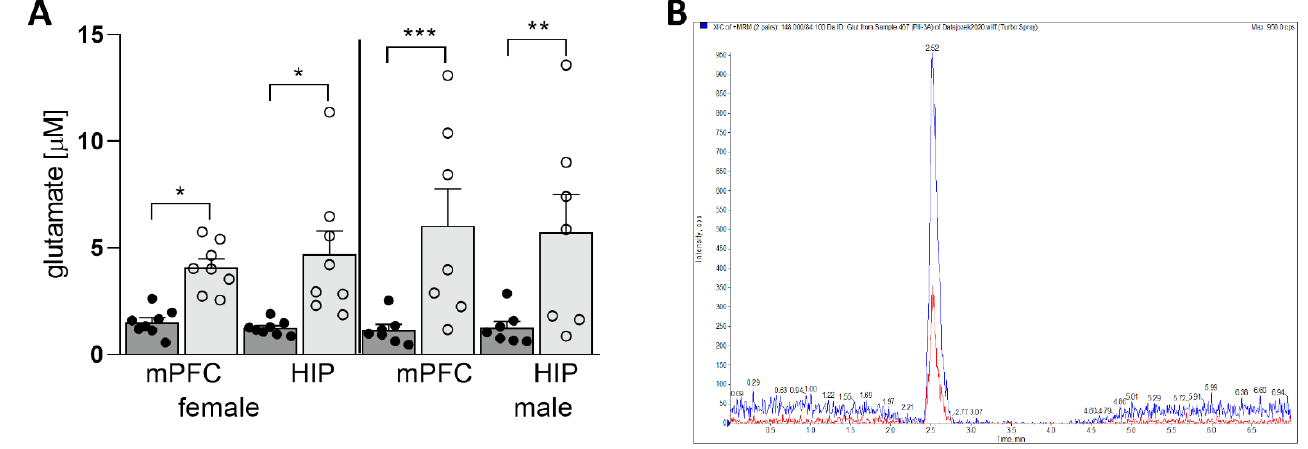
Figure 4. Concentration of extracellular Glu in the mPFC and HIP of the offspring ( A ). SCD — dark gray bars with black dots as individual data points, HSD — light gray bars with transparent dots as individual data points. Representative chromatogram ( B ). Blue peak — Glu; red peak — internal standard (Glu C13). * p < 0.05; ** p ≤ 0.01; *** p ≤ 0.001 .